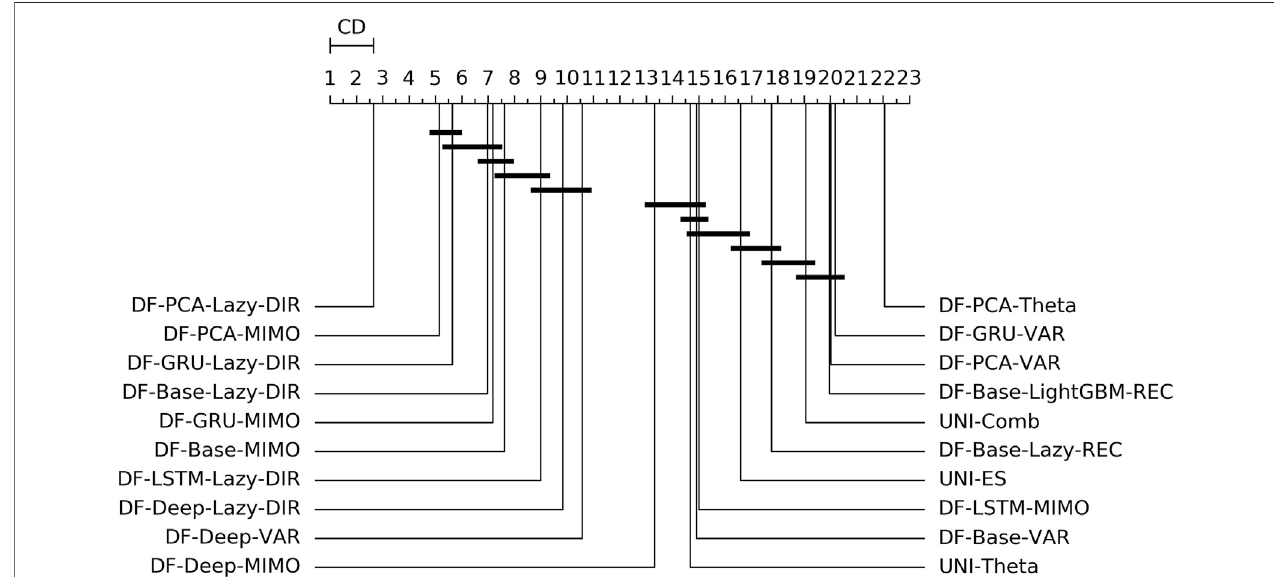
FIGURE 5 | Traf fi c — Graphical representation according to (Dem š ar, 2006) of the results of Friedman statistical test (with post-hoc Nemenyi test) comparing the NNMSE of the best 20 methods against each other, aggregated across all horizons h . The methods are ordered according to their performance from left to right (the leftmost the best), while the black bar connects methods that are not signi fi cantly different (at p (cid:1) 0.05).